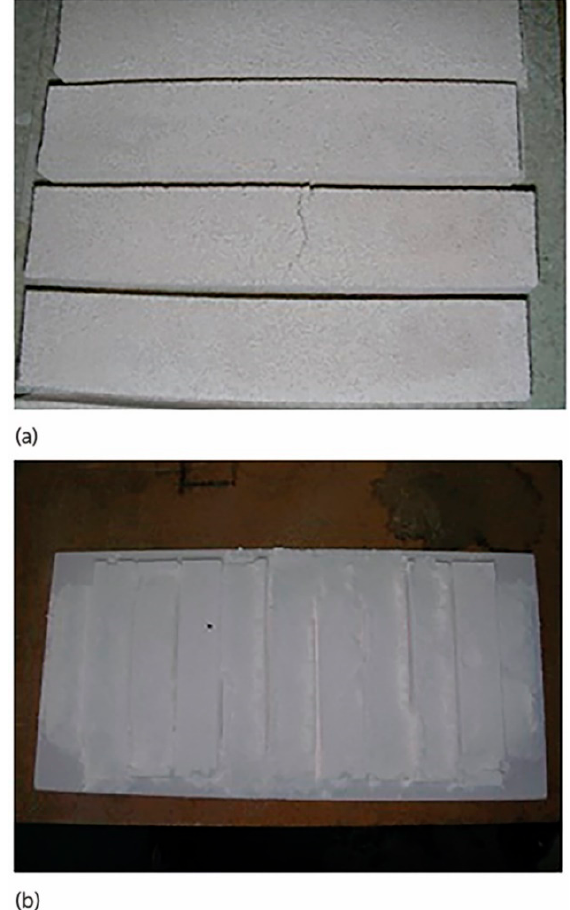
Figure 2. Evidence of cracking upon sintering of 2A type foams owing to interaction with supporting plate ( a ) and structure collapse ( b ) of the 1A type alumina foams after polymer burnout (sample sizes of 150 mm in length; 30 mm in width and 16.5 mm in height).